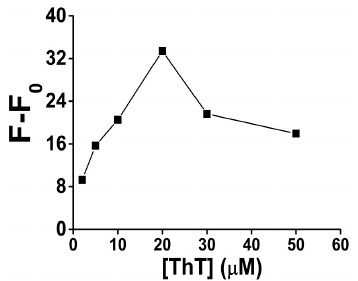
Figure 4. The optimization result of ThT concentration for Pb 2+ sensing in the presence of 100 nM Pb 2+ . [ThT] is the concentration of ThT. Original data for the optimization result of ThT concentration for Pb 2+ sensing shown in Figure S6.